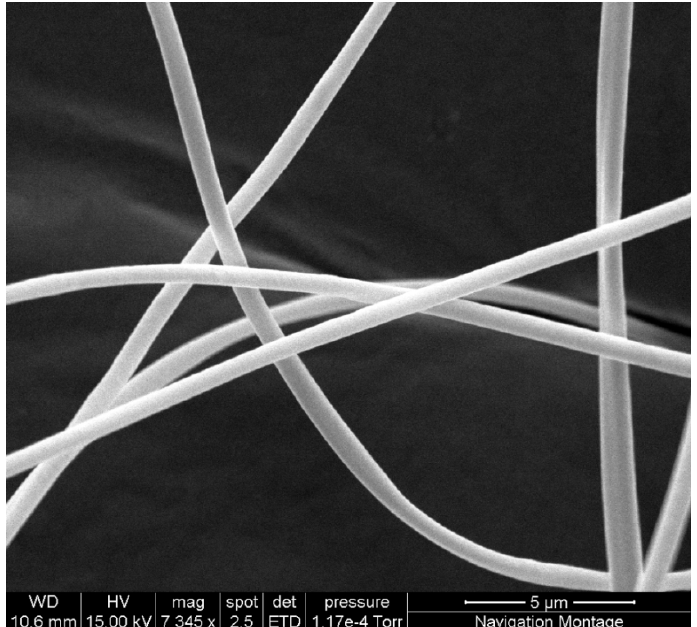
Figure 2. SEM image of regular defect free cellulose acetate nanofibres in the 480 nm range produced using 21.5% cellulose acetate solution, with the spinning parameters of 10 kV, 30 cm needle tip to collecting plate distance and a 5 µL/min flow